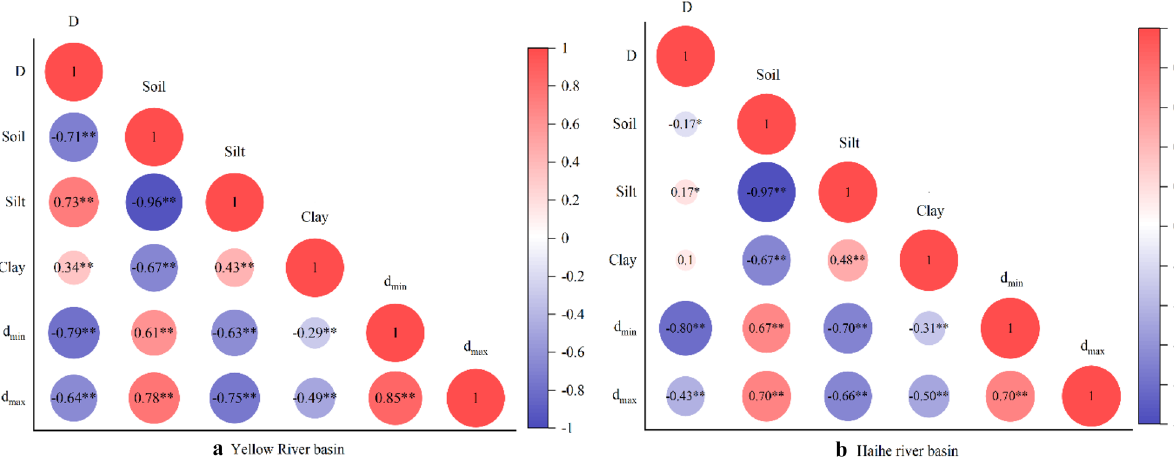
Figure 6. Correlation of soil physical parameters in the Yellow River and Haihe River basins. **Indicates correlation is significant at the 0.01 level; *Indicates correlation is significant at the 0.05